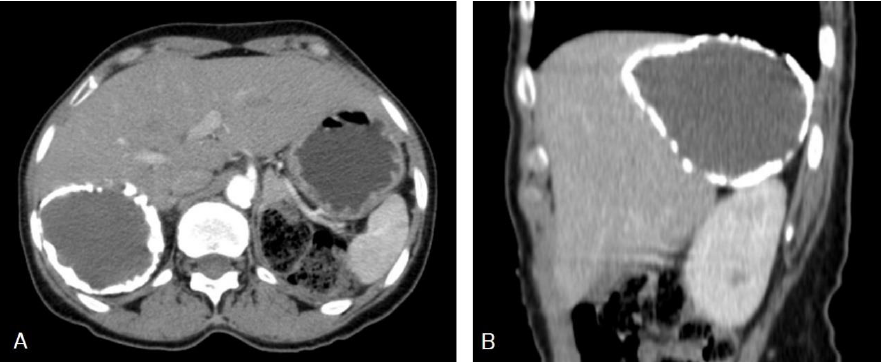
Figure 13. Selected axial ( A ) and sagittal ( B ) CT images of a 50-year-old female presenting with right upper quadrant pain, showing a well-circumscribed unilocular cystic lesion in the right lobe of the liver with calcified margins and no daughter cysts inside it, which is typical of inactive hydatid cyst Type